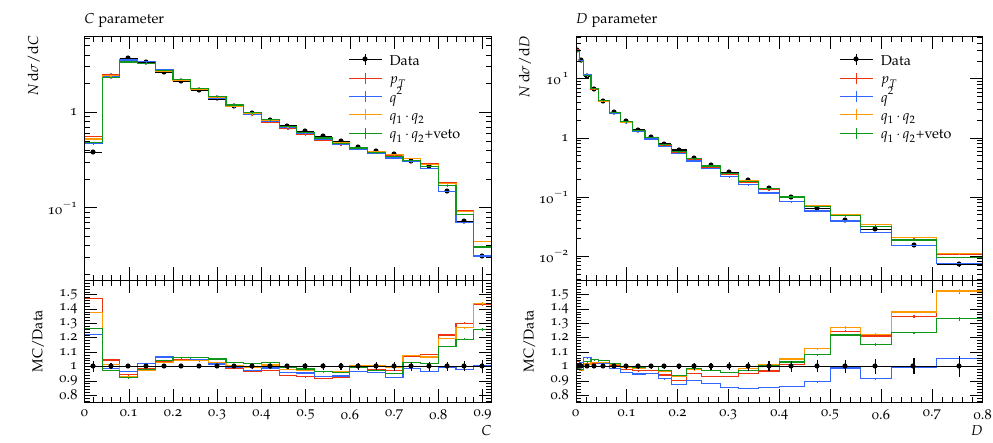
Figure 6 . C (left) and D (right) parameters at the Z-pole compared with data from the DEL- PHI [44] experiment.